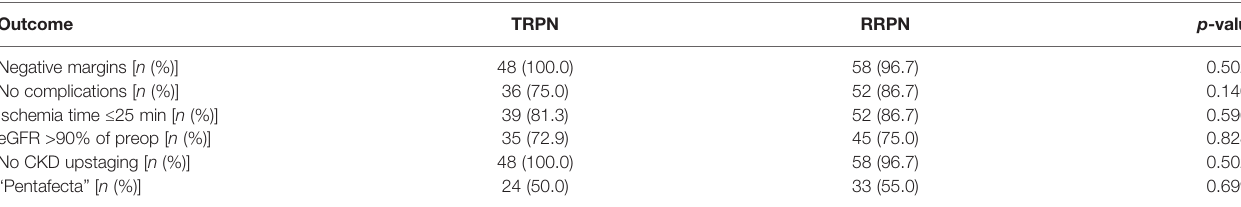
TABLE 4 | Pentafecta analysis comparing TRPN and